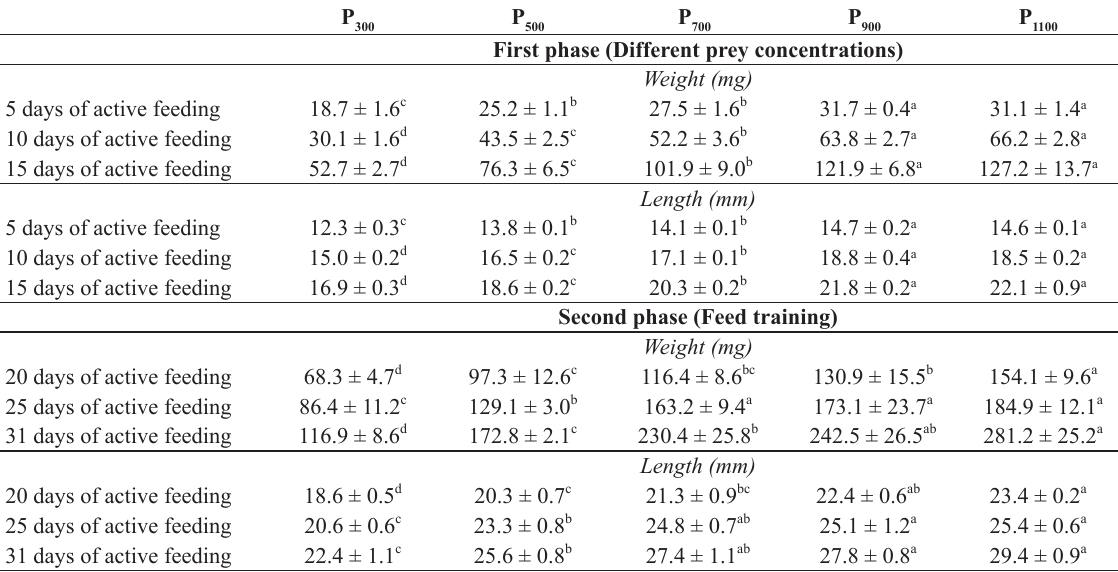
Weight and total length (± standard deviation) of Hoplias lacerdae juveniles during the